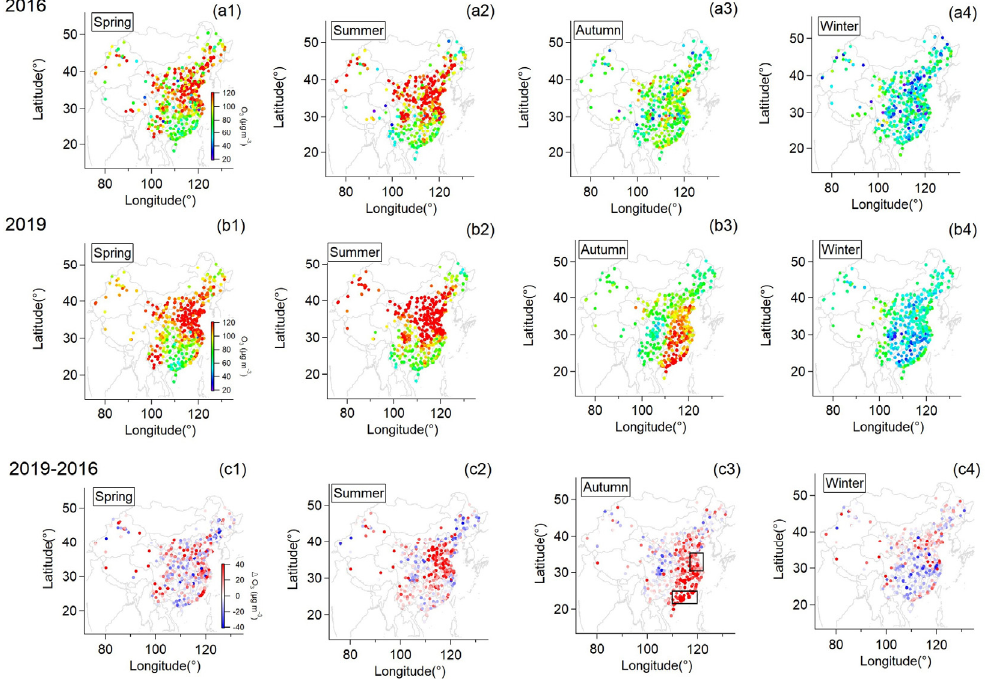
Figure 3. Seasonal mean surface daily maximum 8h average (MDA8) O 3 at individual monitoring stations for 2016 ( a1 – a4 ) and 2019 ( b1 – b4 ); The difference in surface MDA8 O 3 between the two years ( c1 – c4 ).